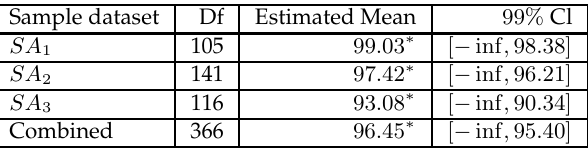
Table 7: One-tailed t-test of sketch aspect